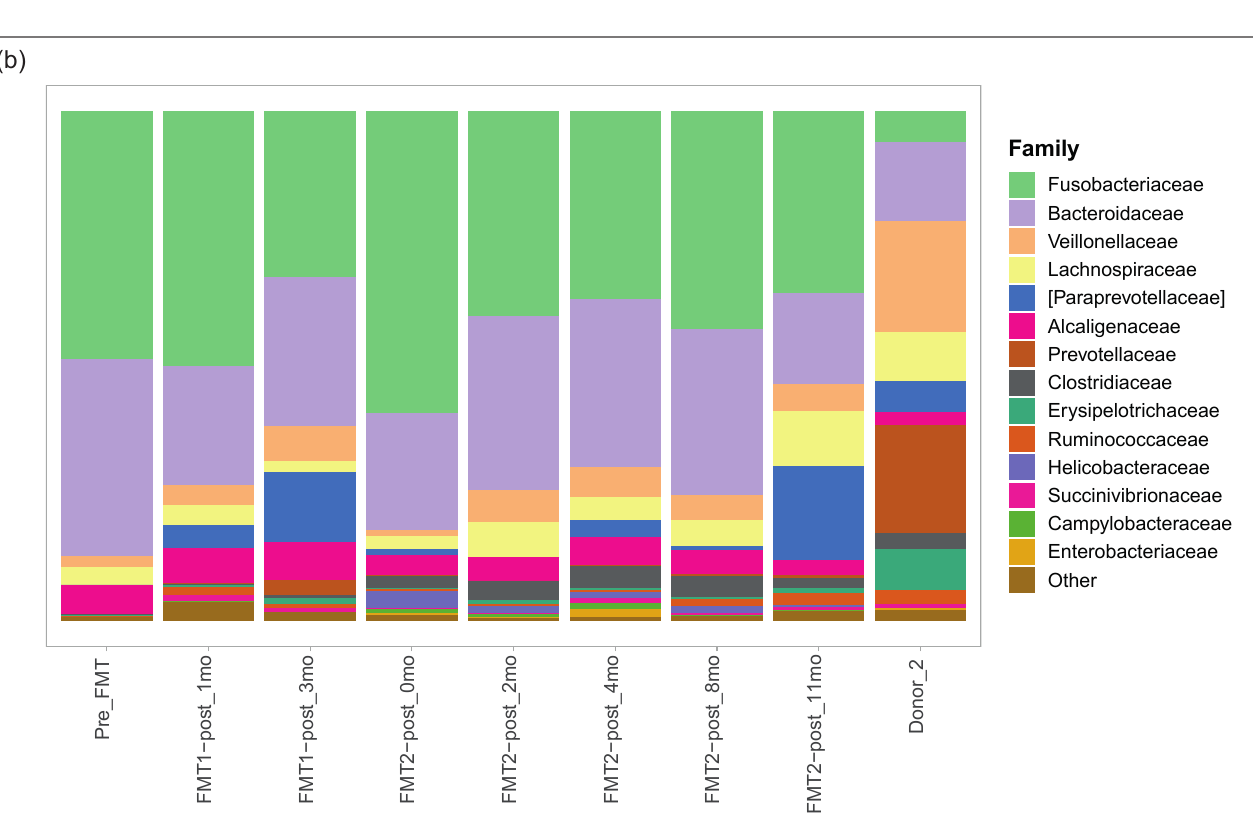
Figure 1. Donors’ and receiver’s faecal microbiome composition. The microbial composition of each sample is represented by means of a stacked bar plot. ( a ) Microbial composition at phylum level; ( b ) Microbial composition at family level. The most proportionally abundant (in mean) families are explicitly shown, while the remaining portion of microbial contributions is grouped in the Other category. Donor_1 information was only included at phylum level (see